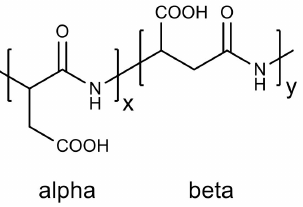
Figure 10. The structure of polyaspartic acid with alpha- and